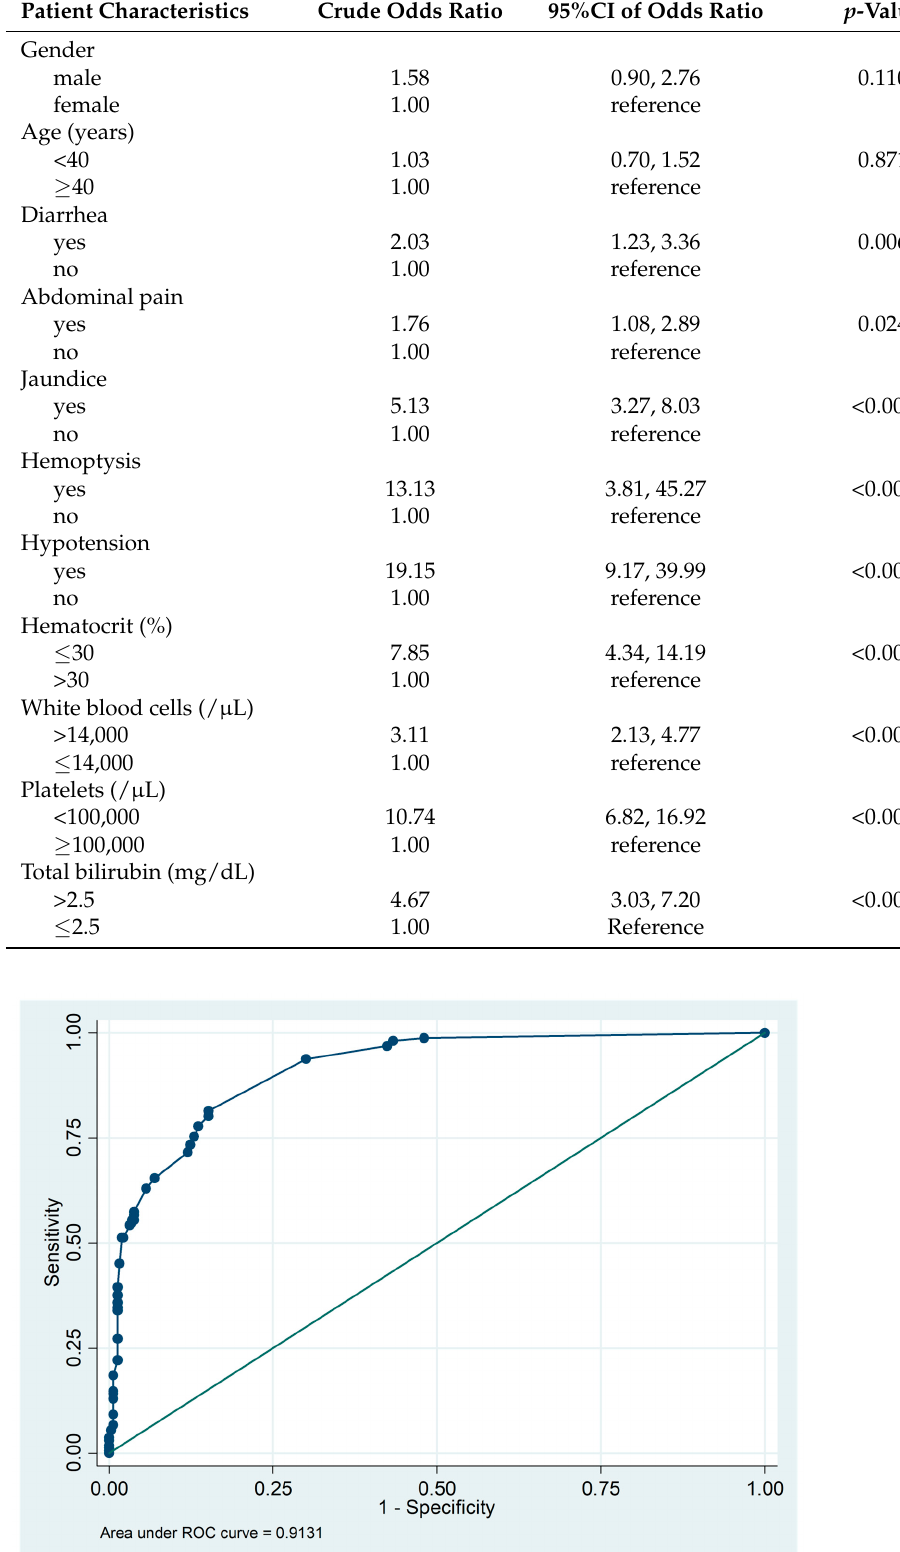
Figure 2. Discrimination of predictors with an area under the receiver operation curve (AuROC).